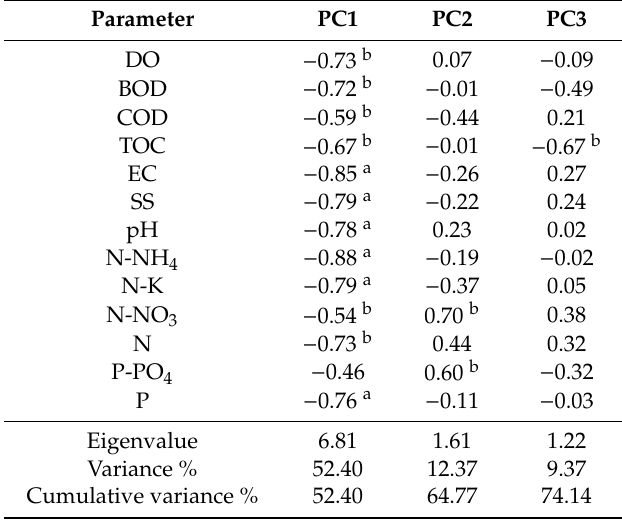
Table 3. Matrix of factor loadings calculated on the basis of water quality parameters.